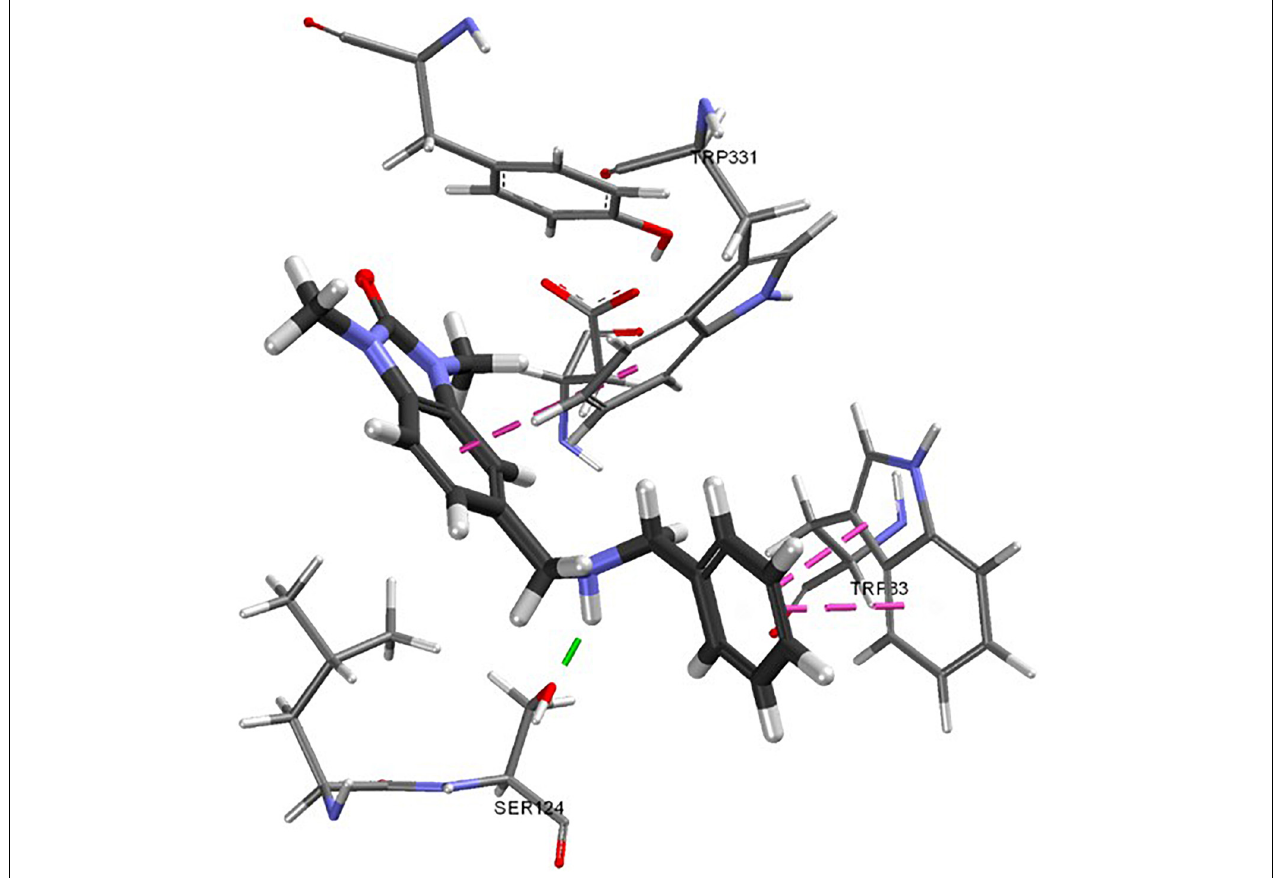
FIGURE 4 | Predicted binding of 9j to the homology model. Green dashes indicate hydrogen bonding interactions, pink dashes indicate π - π